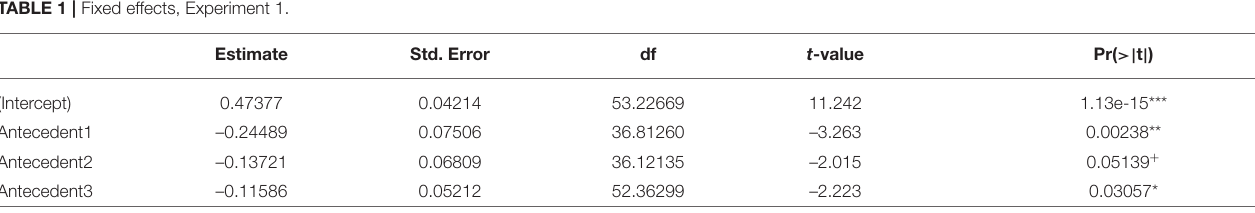
TABLE 1 | Fixed effects, Experiment